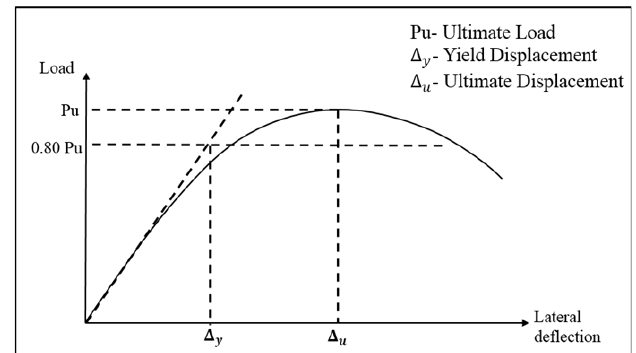
Figure 9. Evaluation of the yield and ultimate displacements [43]. Table 3. Ductility values of CFS beams.